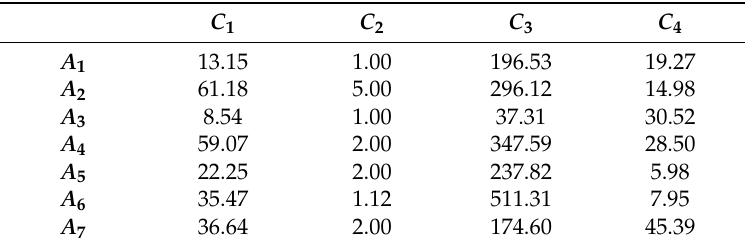
Table 10. Average of actual numerical value of criteria.